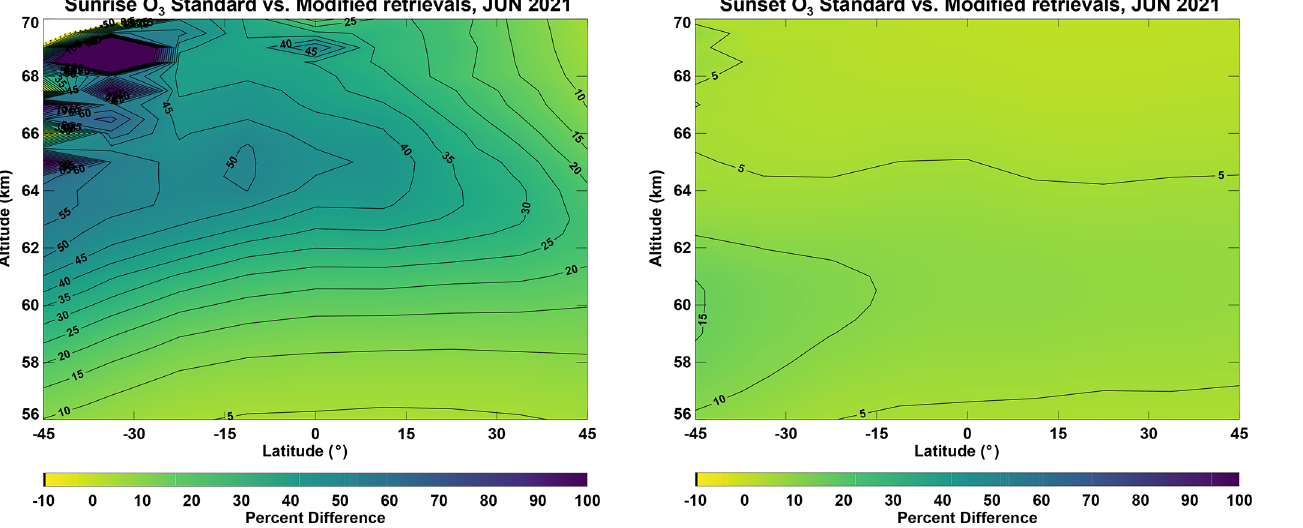
Figure 9. Latitudinal average of the percent difference in sunrise O 3 between the standard (archived) retrieval and a retrieval includ- ing diurnal variations along the LOS, as a function of latitude and altitude for June 2021.